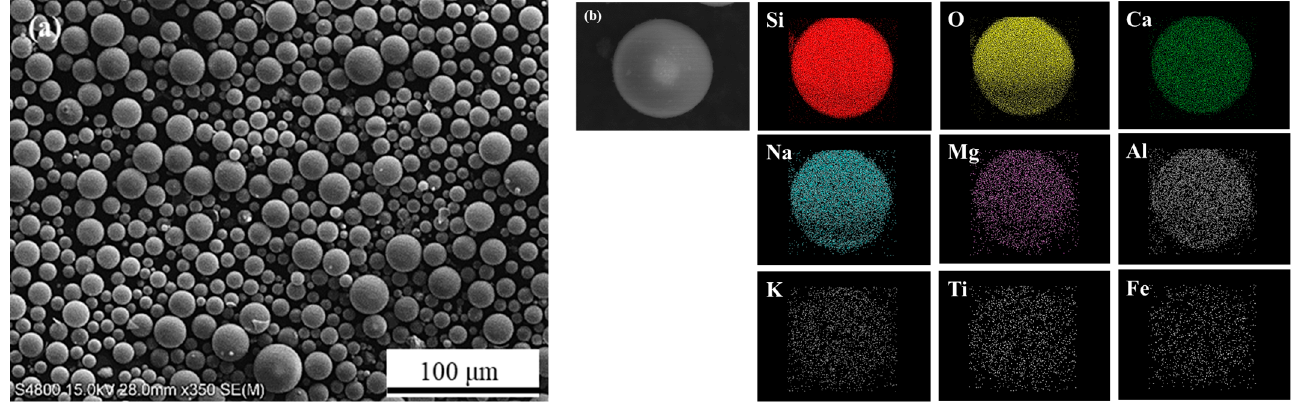
Figure 3. ( a ) SEM image of GHS; ( b ) EDS map for the microstructure of the GHS. Table 4. EDS results for raw